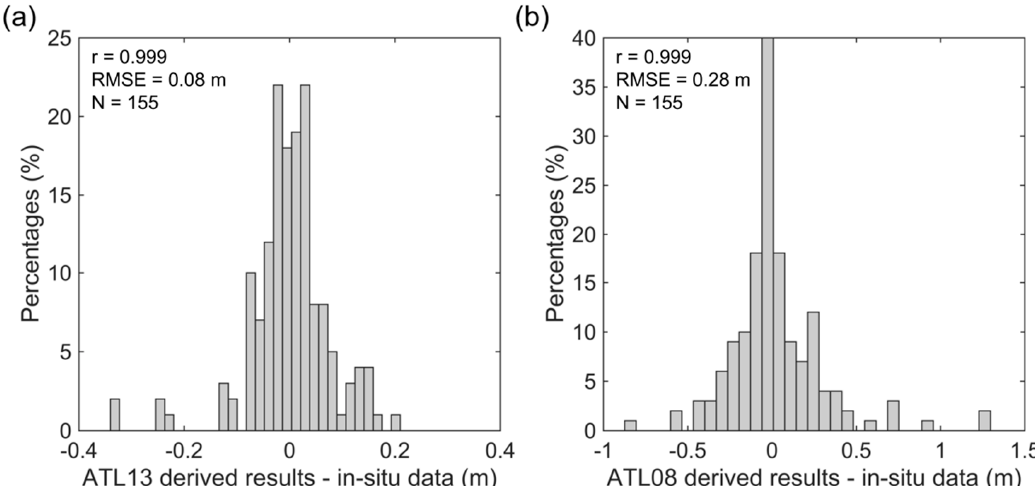
Figure 8. ( a ) Histograms of differences between monthly water levels from our ATL13-derived results and in situ water level data of 16 lakes/reservoirs in the United States (ID: 1–16) and 11 lakes/reservoirs in Australia (ID: 17–27). ( b ) Histograms of differences between monthly water levels from ATL08-derived results in the study by Cooley et al. [28] and in situ water level data. The lake/reservoir ID numbers are consistent with those in Figure 6. Note that all water levels from ATL13-derived results, ATL08-derived results, and in situ measurements were based on or transformed into orthometric heights with respect to the EGM2008 geoid for each lake/reservoir.